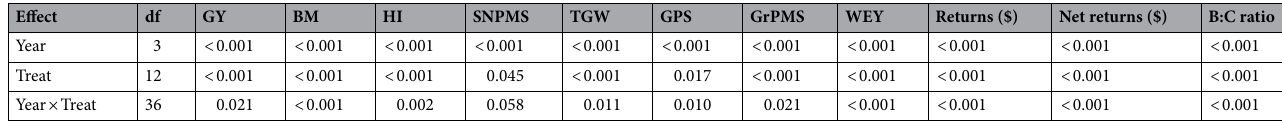
Table 2. Analysis of variance of maize + pulse-wheat intercropping